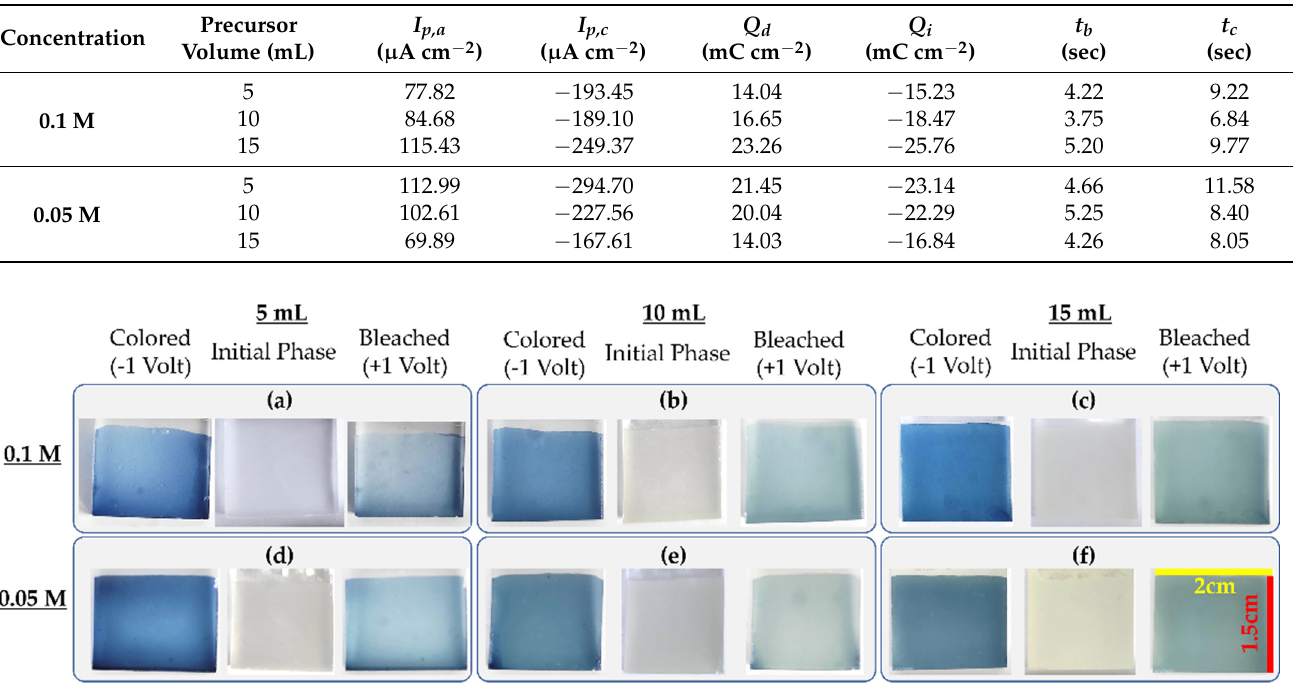
Table 1. Electrochemical properties of WO 3 films.